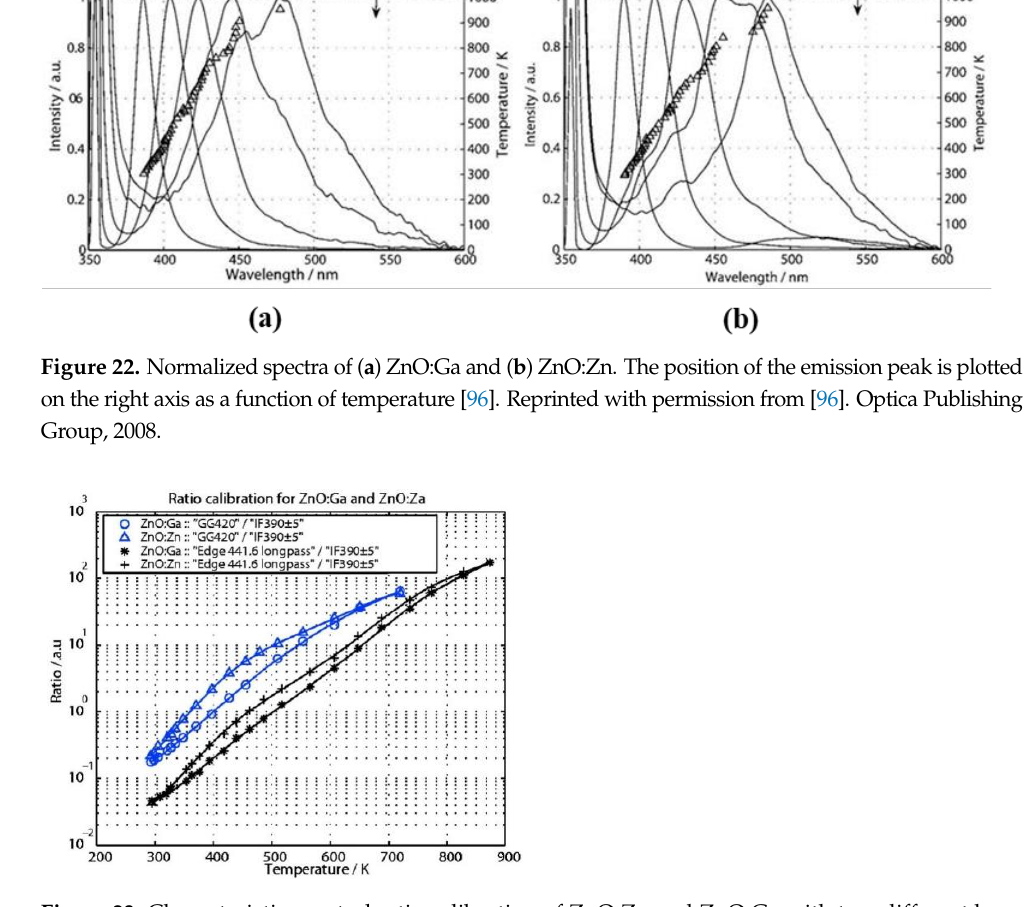
Figure 24. ( a ) A falling, burning methanol droplet photographed by an ICCD camera without filters; ( b ) a temperature image of a free-falling methanol droplet burning in the middle of the Bunsen burner [96]. Reprinted with permission from [96]. Optica Publishing Group, 2008. In recent years, more and more researchers have applied the LIP technique to the temperature measurements of droplets or sprays. In 2020, Strizhak et al. [134] selected BaMgAl 10 O 17 :Eu 2+ (BAM:Eu) as the phosphor and used the ratio method to study the drop- let temperature field of four types of widely used liquids (water, kerosene, diesel, and gasoline). They analyzed the effect of different factors, such as phosphor concentration and droplet heating rate, on the temperature measurement results. Subsequently, other researchers of their group [135] analyzed for the first time the difference between the LIP technique and contact measurement techniques for measuring droplet temperatures of gas – vapor mixtures. They found that the LIP technique was more efficient in terms of the number of simultaneous measurement points, recording speed, peak temperature record- ing (both maximum and minimum), and the ability to conduct measurement with exten- sive phase transformations [135]. In addition, they also applied this technique to a 2D temperature measurement of fuel water-in-biodiesel microemulsions in the Leiden frost state, in which the forced convection in the drops was studied and the maximum temper- atures at which the droplet began to puff were established [136]. 4.3. Internal Combustion Engines The temperature of the combustion chamber wall, piston, valves, and other compo- nents of an internal combustion engine is an important parameter for engine efficiency evaluation and lifetime prediction. Before the application of laser diagnostic technology, researchers mainly used various temperature sensors (thermocouples, thermistors, etc.)